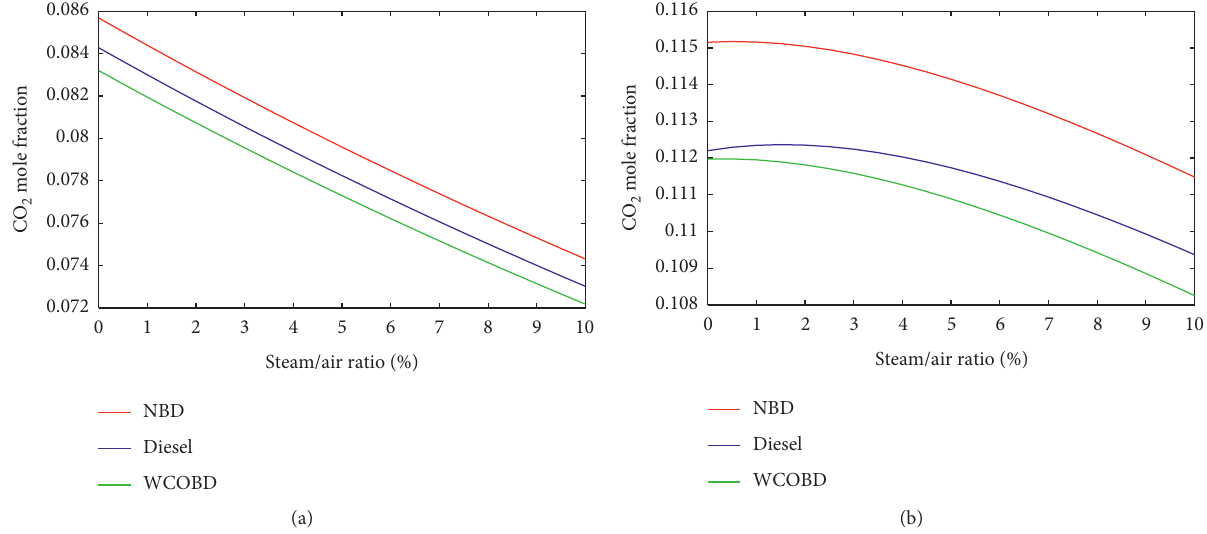
Figure 1: Variation of CO 2 equilibrium mole fractions with steam injection ratios.